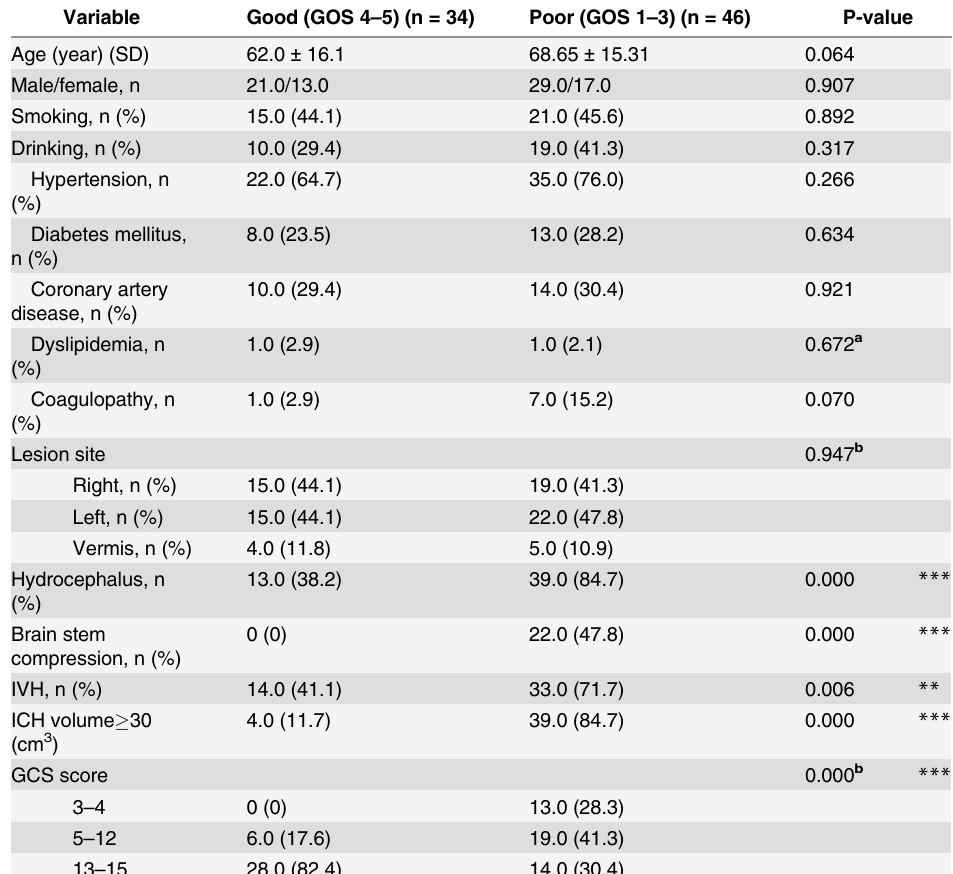
Table 2. The baseline characteristics and comparison of demographic data of the study